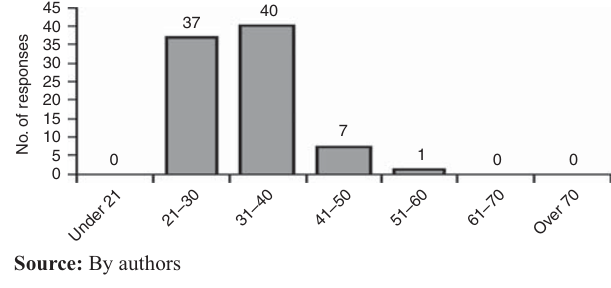
Figure 2. Age range of participants as reported from